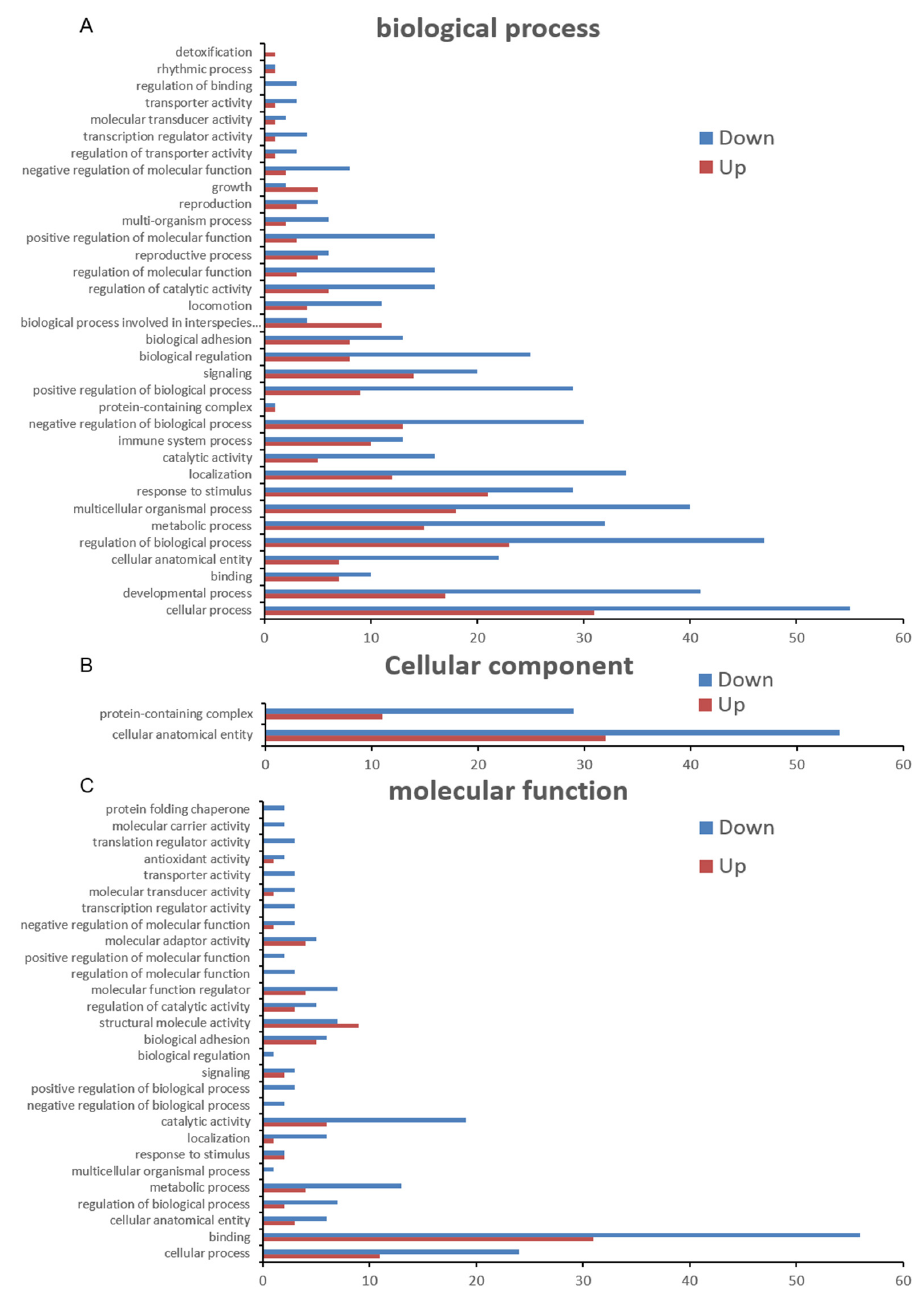
Figure 3. Gene Ontology (GO) annotation for the precursor proteins of the significantly DEPs. ( A ) Biological process; ( B ) Cellular component; ( C ) Molecular function.